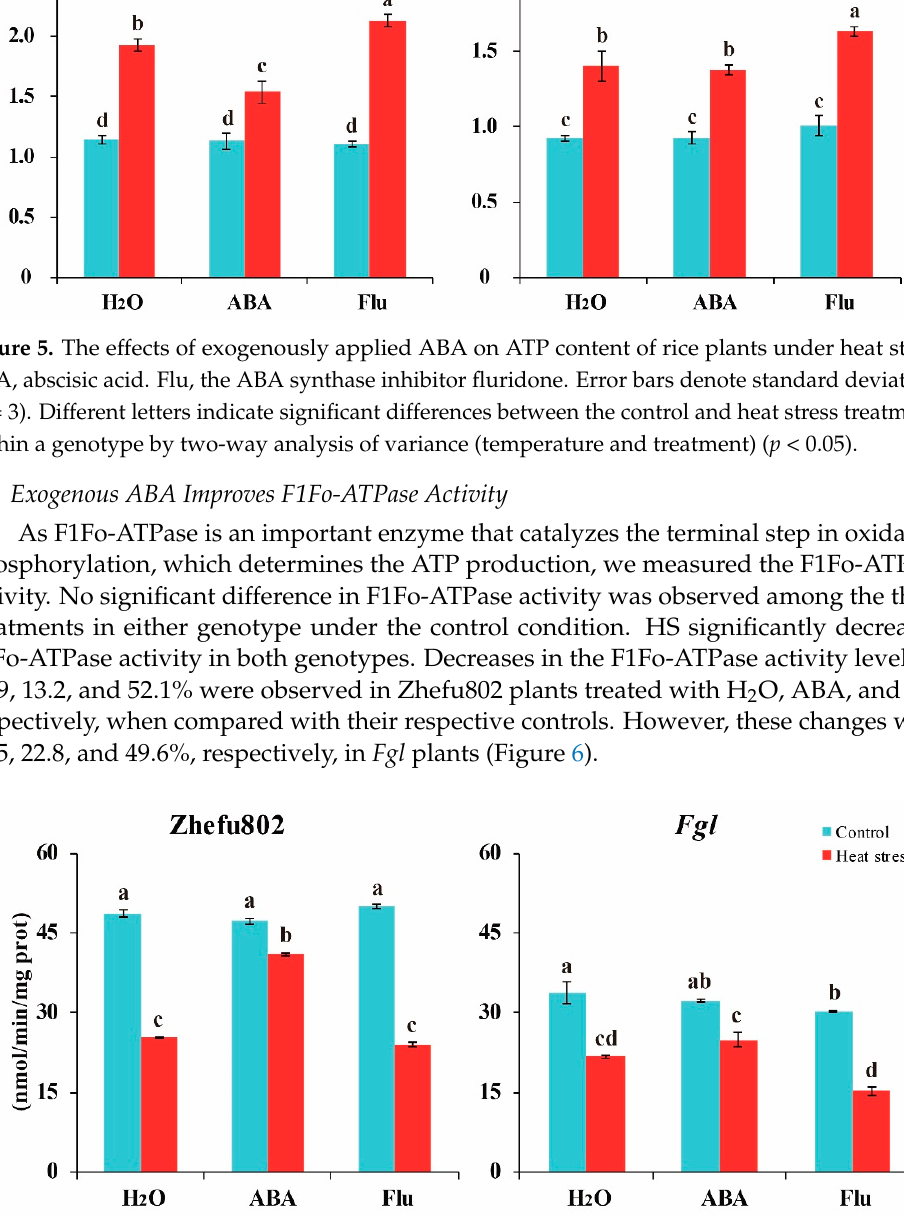
Figure 6. The effects of exogenously applied ABA on F1Fo-ATPase activity of rice plants under heat stress. ABA, abscisic acid. Flu, the ABA synthase inhibitor fluridone. Error bars denote standard deviations ( n = 3). Different letters indicate significant differences between the control and heat stress treatments within a genotype by two-way analysis of variance (temperature and treatment) ( p < 0.05).